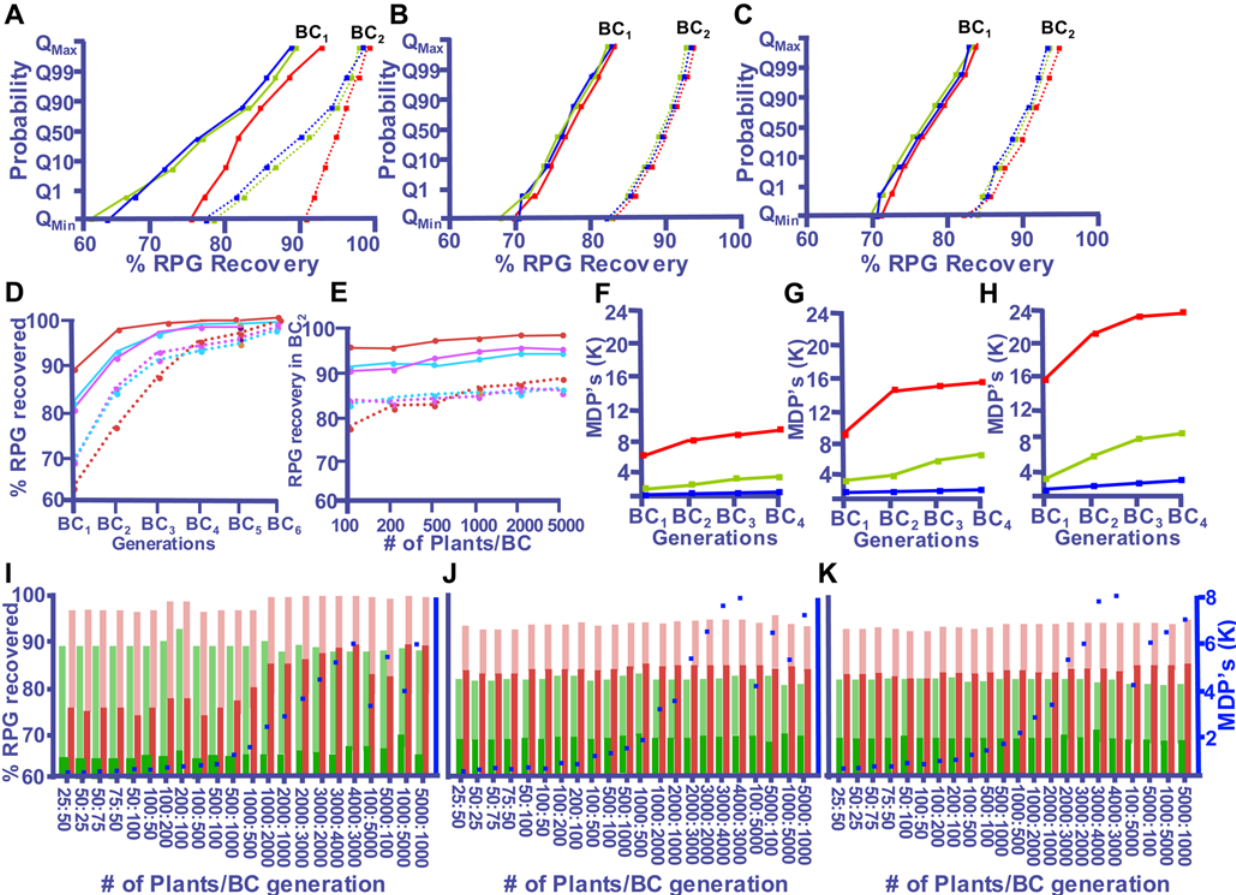
Figure 1. Computer simulations to optimize MABS approach in wheat. (A–C) Plabsim results for RPG recovery at different Q-values including the minimum and maximum value using 110 (A), 208 (B) and 320 (C) markers for two-stage (red line), three-stage (green line) and four-stage (blue line) selection. (D–E) Represents %RPG recovered with increasing BC generation at constant population size of 100 per BC (D), and with constant increase in population size (E), using 110 (red line), 208 (blue lines) and 320 (pink lines) markers and four-stage selection strategy. Solid lines corresponds to Q max values, whereas dotted lines represents Q min values. (F–H) Corresponds to the number of MDP required in each generation using two- (red line), three- (green line) and four-stage (blue line) selection strategy for 208 (F), 110 (G) and 320 (H) markers. (I–K) Represents the Q max (shaded bars) and Q min values (solid bars) of RPG recovery in BC 1 (green bars) and BC 2 (red bars) generation using variable population size per BC and four-stage selection, and for 110 (I), 208 (J) and 320 (K) markers. Blue dots correspond to the number of MDPs